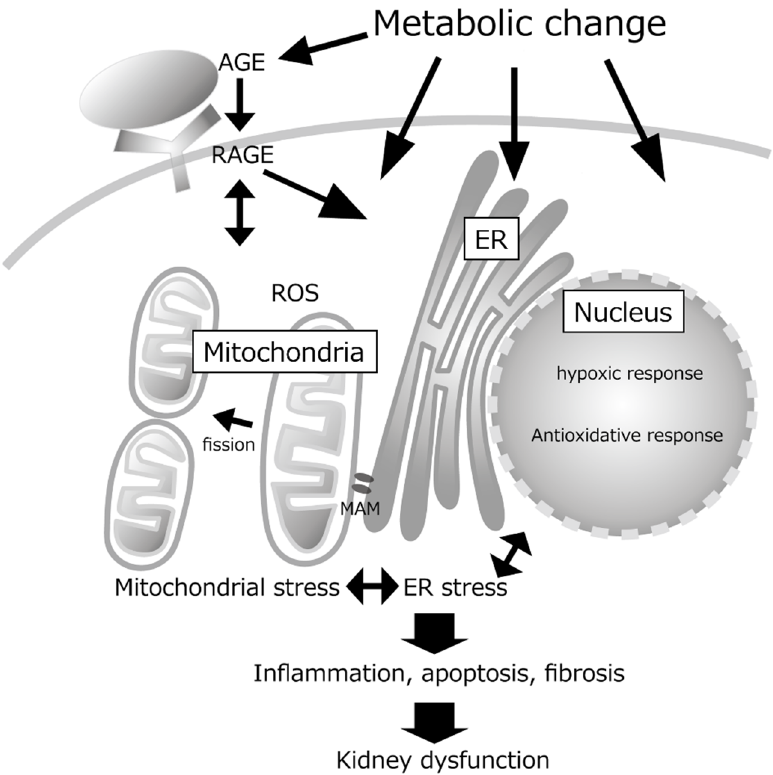
Figure 1. Organelle crosstalk and interconnected stress response. Metabolic changes in DKD induces organelle stresses including mitochondrial stress and endoplasmic reticulum (ER) stress. These organelle stress together with advanced glycation end products (AGEs) cause inflammation, apoptosis, and fibrosis, resulting in kidney dysfunction.